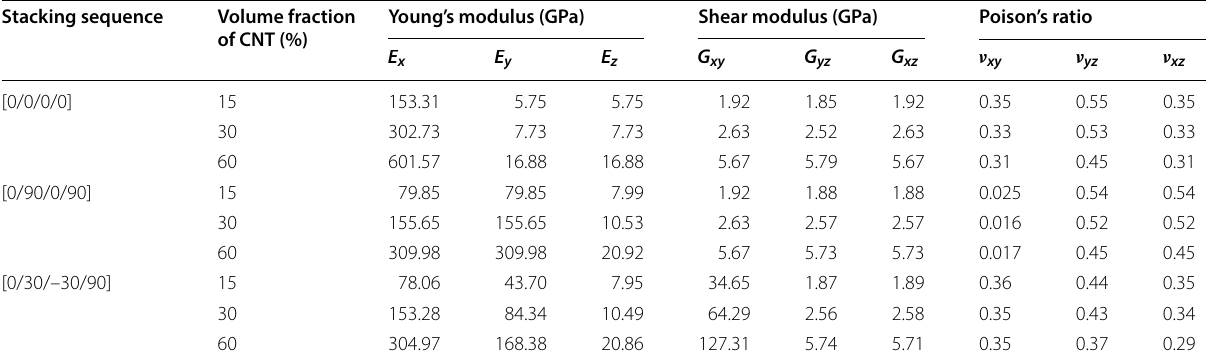
Table 2 Elastic properties of CNT/epoxy laminated composites at different CNT volume fractions Stacking sequence